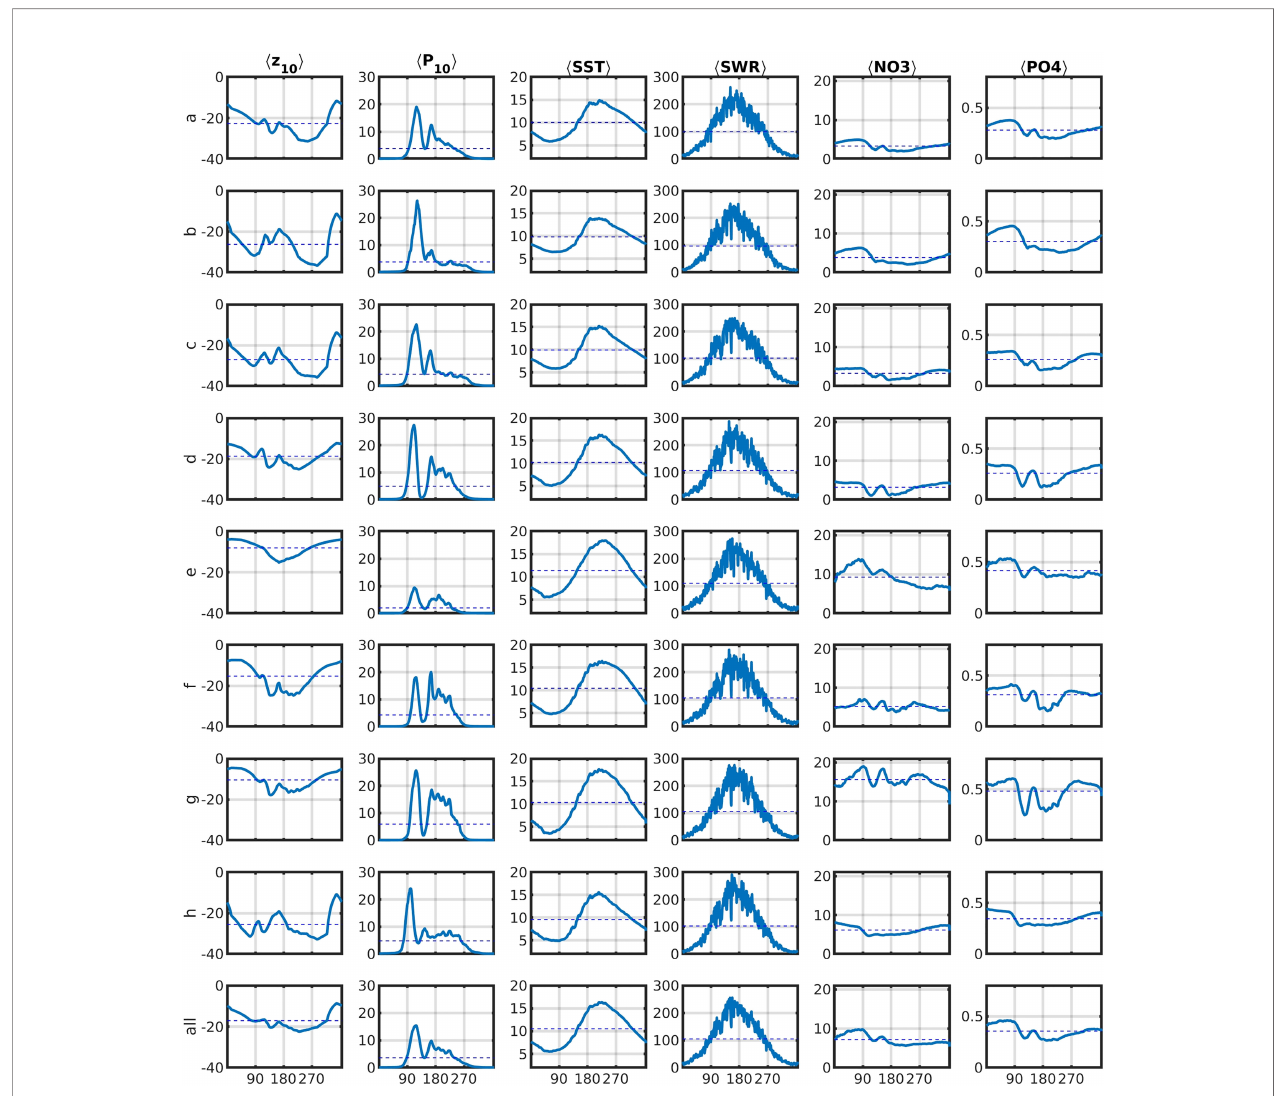
FIGURE 3 | Daily climatologies of <Z 10 > [ m ], <P 10 > [ mmolNm -3 ], < SST > [ C], < SWR > [ W m -2 ], < NO 3> [ mmolNm -3 ] and <PO4> [ mmolNm -3 ] of all areas (see Figure 1 ) for r2000. Dashed lines denote 5-year